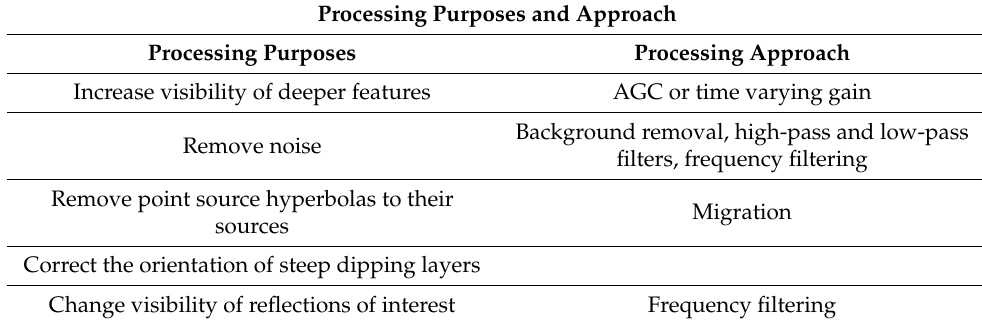
Table 1. List of processing purposes and the approach that should be used to accomplish them for GPR data, as per Conyers [30].